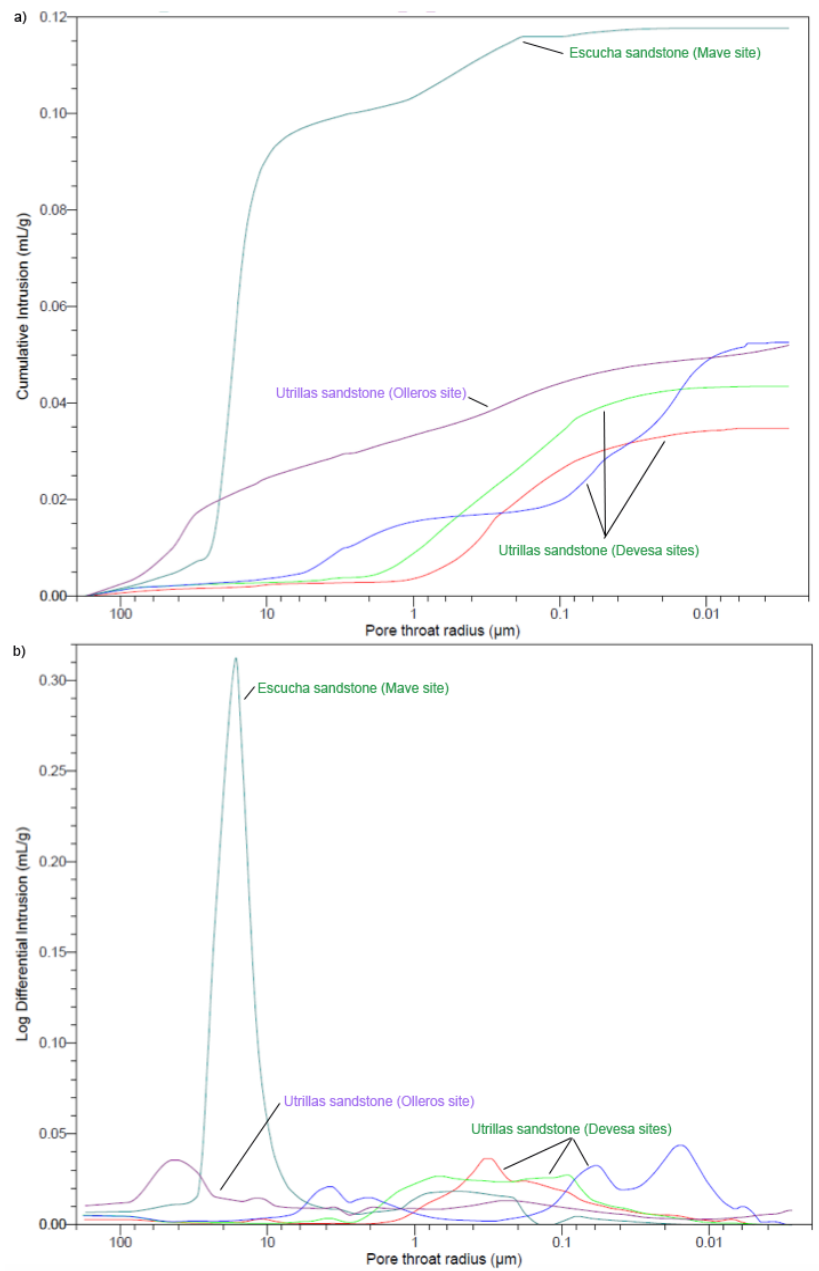
Figure 7. Typified mercury intrusion curves ( a ) and pore throat radius distribution ( b ) of the studied sandstones. The homogeneous Escucha sandstones can be represented by a single typified curve (dark green), while for the Utrillas sandstones four typified curves were obtained: one for the Olleros site (purple) and three for the Devesa site (red, blue and light green).